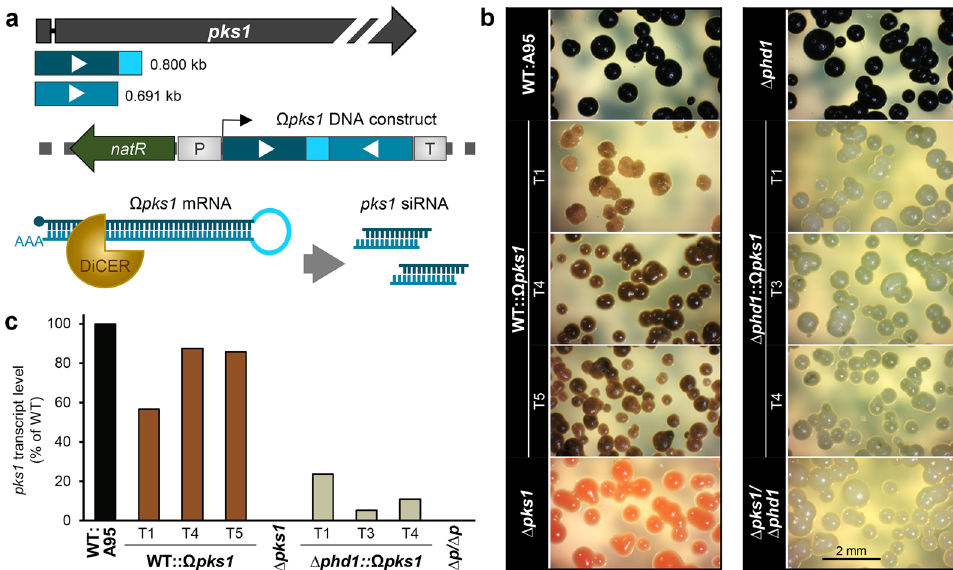
Figure 6. Gene silencing by RNA interference (RNAi). ( a ) Strategy for the endogenous formation of siRNA targeting pks1 mRNA. Two amplicons covering the 5 ′ -region of pks1 and containing specific overhangs for cloning were introduced in digested pNAN-OGG resulting in the Ω pks1 (hairpin) construct under control of A. nidulans P oliC (Table S1). Transcription results in hairpin-mRNA (double stranded, dsRNA) which is cleaved by the endoribonuclease Dicer into single-stranded small interfering RNA (siRNA). WT:A95 and the car -deficient mutant ∆ phd1 were transformed (Table S3) with the linearised plasmid and natR transformants were